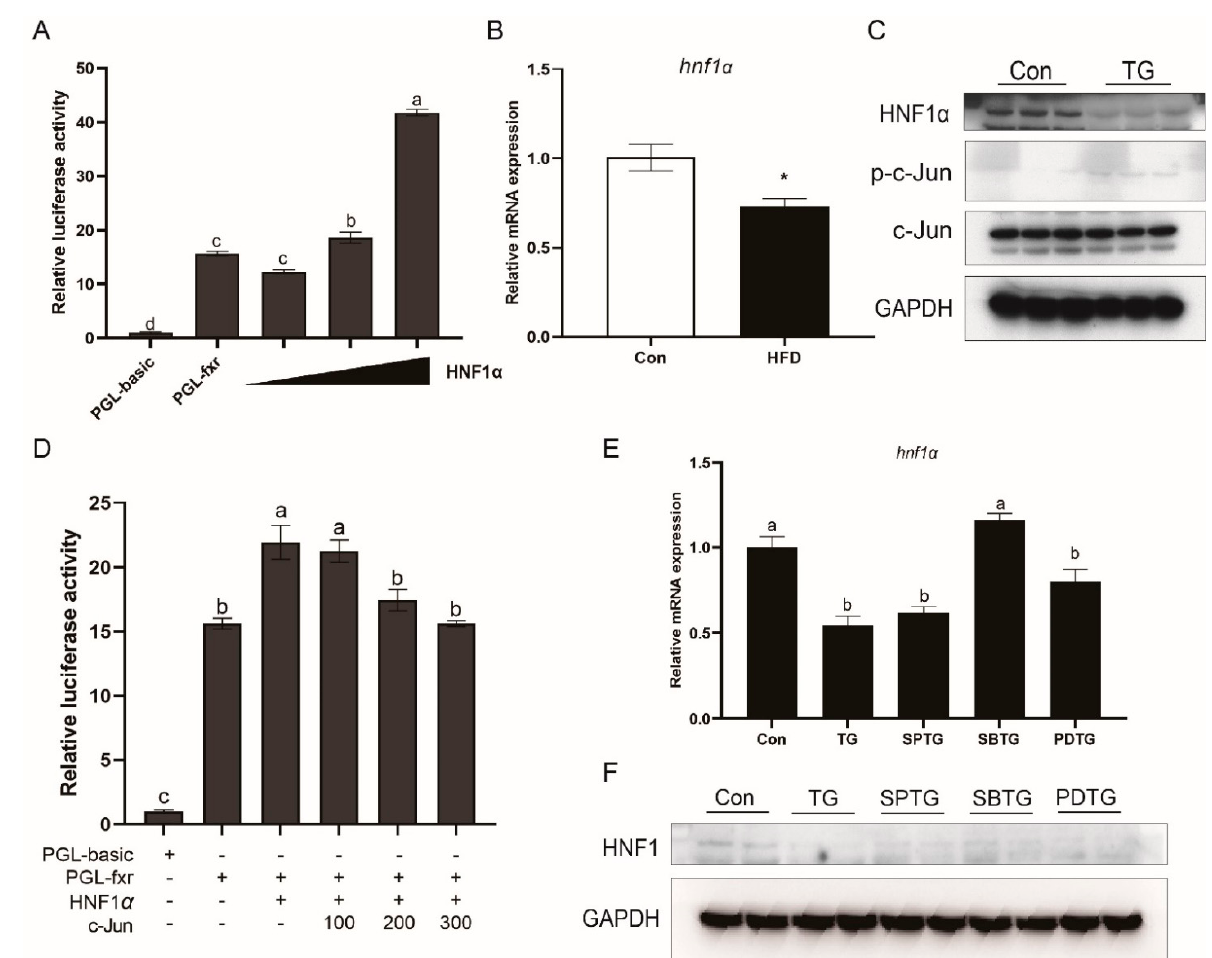
Figure 8. HNF1 α is involved in er stress effect on FXR. ( A ) Promoter activity of croaker FXR in HEK 293T cells after HNF1 α overexpression. ( B ) qRT-PCR assays for HNF1 α in the liver of large yellow croakers fed HFD diet. ( C ) Immunoblots for HNF1 α and c-Jun in LYCL cells after TG treatment. ( D ) Promoter activity of croaker FXR in HEK 293T cells after HNF1 overexpression alone or co-transfected with c-Jun. ( E , F ) Immunoblots or qRT-PCR assays for HNF1 α in LYCL cells after TG treatment alone or with MAPK inhibitors. Data are shown as means ± SEMs ( n = 3) and were analyzed using Duncan’s multiple range test and Student’s t -test. The letters a–c indicate that there is a significant differences between the means, * p < 0.05.